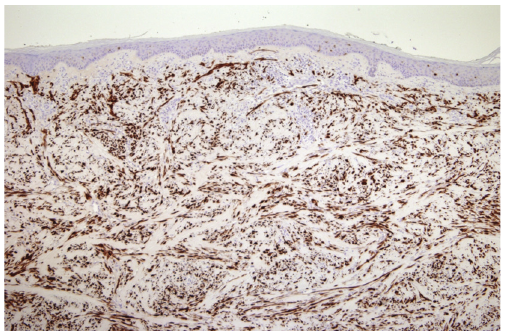
Figure 3: Desmoplastic melanoma: S-100 immunoreactivity in the dermal spindle cells (original magnification ×